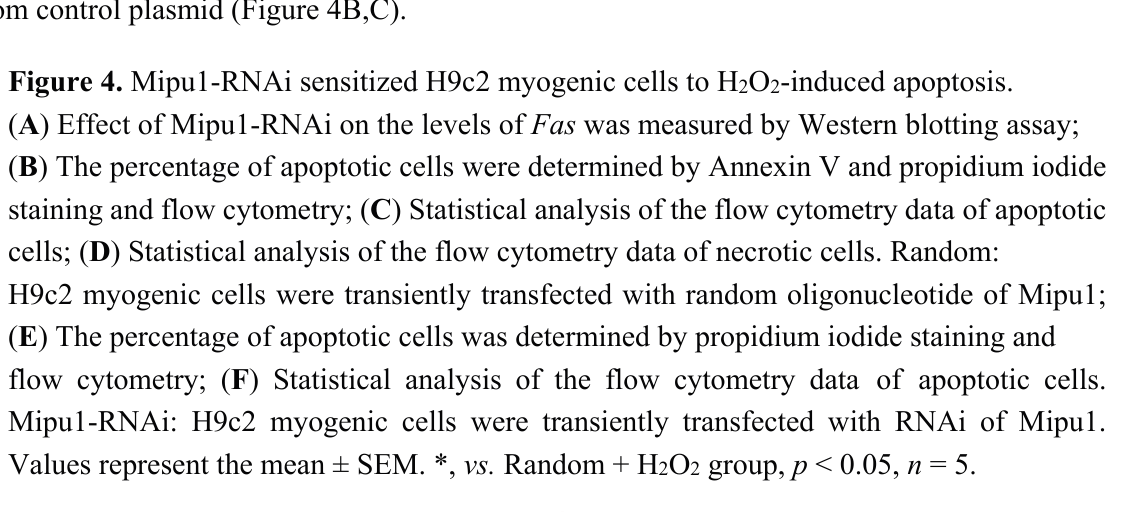
Figure 4. Mipu1-RNAi sensitized H9c2 myogenic cells to H 2 O 2 -induced